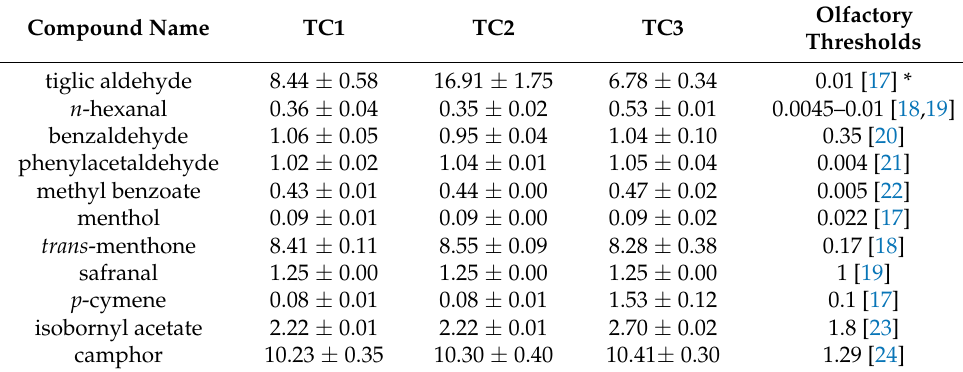
Table 3. Contents of the most relevant volatile constituents in commercial samples TC1–TC3 as well as olfactory thresholds reported in the literature. Quantitative results are given in mg/kg dried plant material and olfactory thresholds are given in ppm in aqueous solutions.